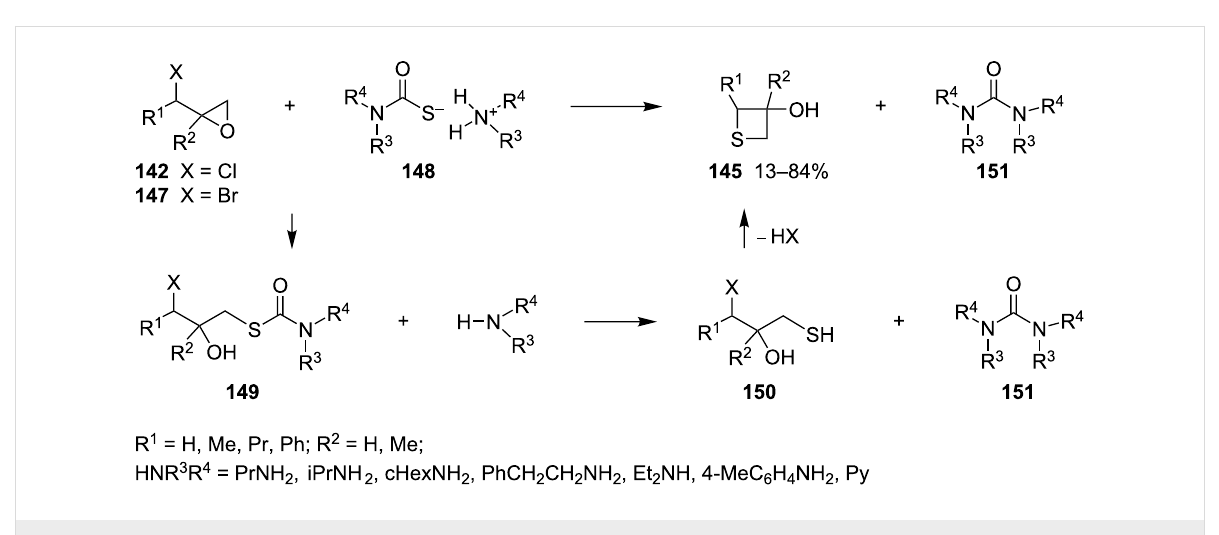
Scheme 30: Synthesis of thietane-3-ols 145 from 2-(1-haloalkyl)oxiranes 142 and 147 with ammonium monothiocarbamates 148 .